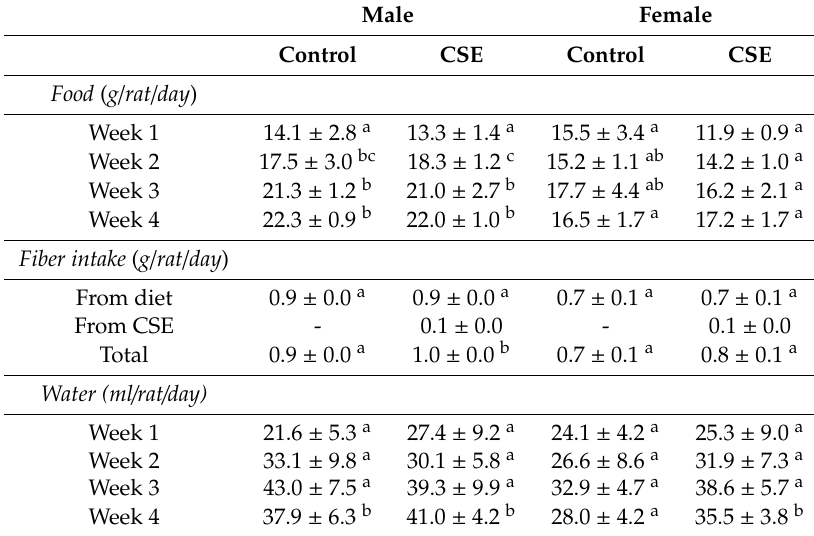
Table 2. Food, fiber (3.9 % of fiber from diet) and water intakes of control rats ( n = 15) and rats treated with CSE (1 g / kg b.w.) ( n = 15) during repeated dose toxicity